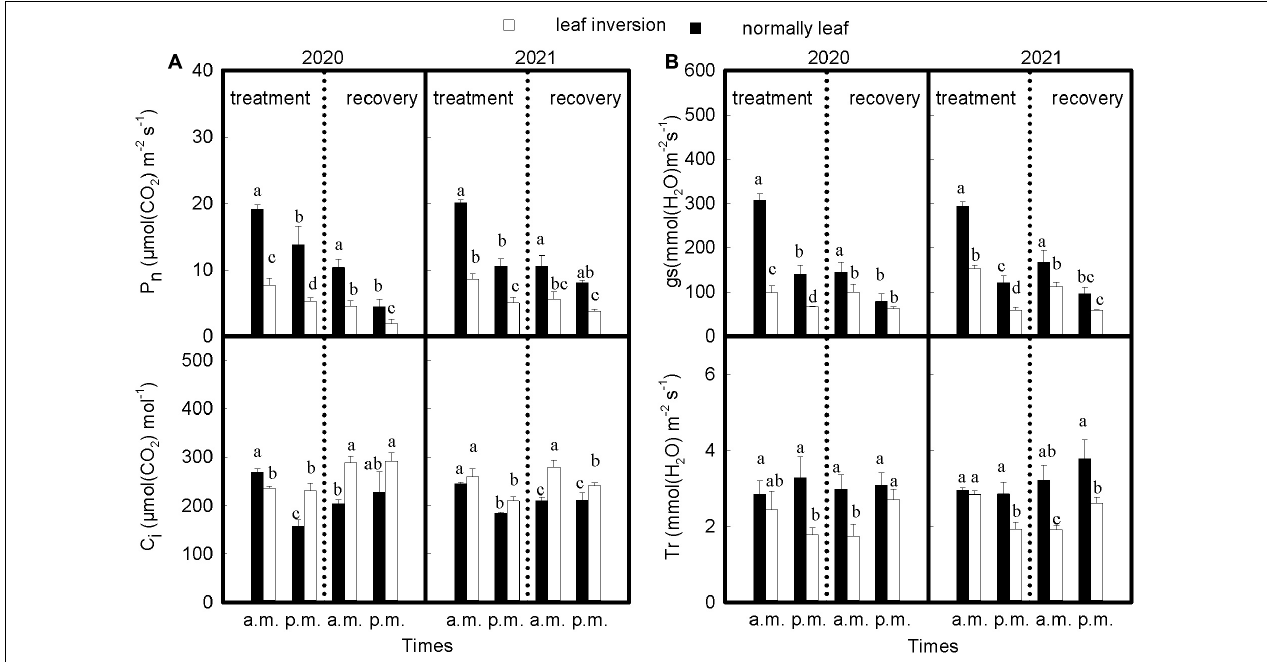
FIGURE 2 | (A,B) The gas exchange parameters of both treatments during 2020 and 2021 at 9 a.m. and 4 p.m. Data are expressed as means ± SEs ( n = 3). P n , net photosynthetic rate; C